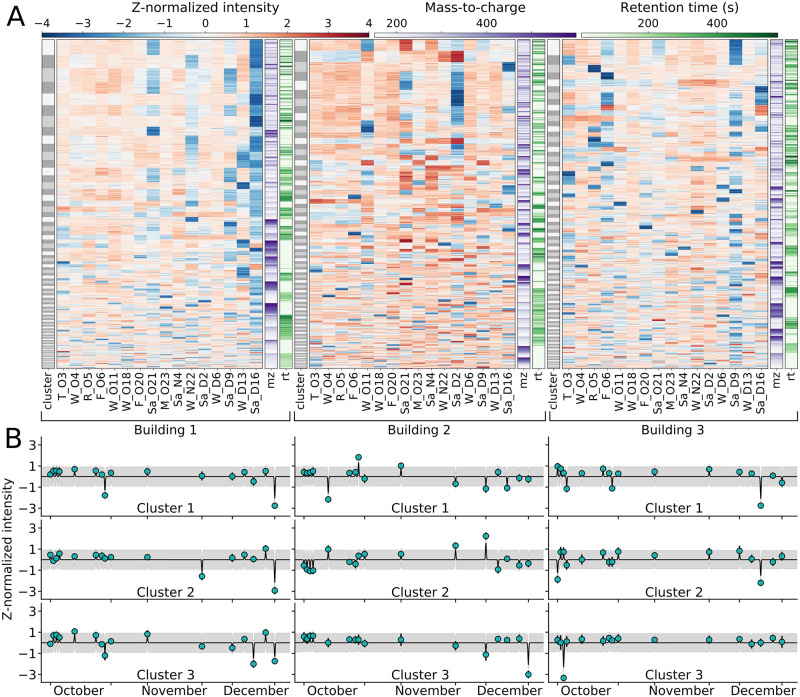
Individual buildings possess unique fTDs with most dynamics governed by a few clusters and large, single day deviations from the mean.(A) Summary of all building data sets using only shared sampling days. Gray columns show the 100 clusters, with individual box heights corresponding to cluster size. The 16 red and blue columns depict single-day, z-normalized log intensities for each feature (individual rows) for the three buildings; purple and green columns show feature mz and rt respectively. Color keys shown above the plots. (B) Average cluster values (teal points) for the three largest clusters for each building, with each cluster fit to a GP. Model standard deviation in gray.